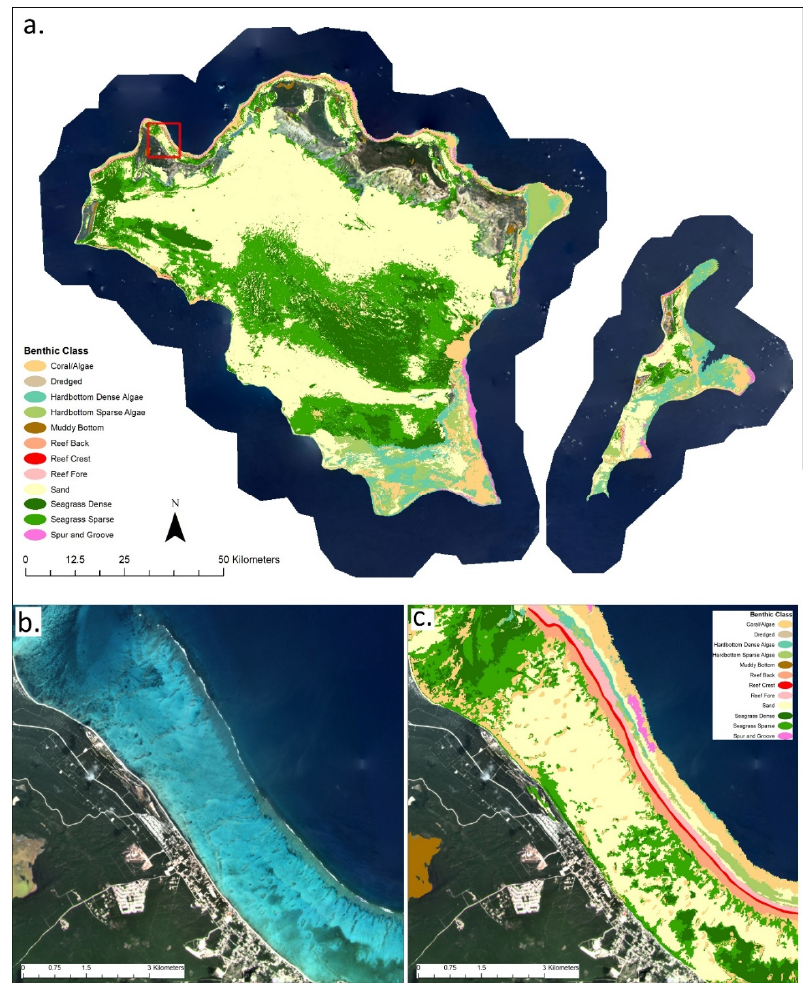
Figure 10. ( a ) An example area of the final PS image-derived benthic habitat classification for the Turks and Caicos Islands; ( b ) Zoomed-in area on the west side of Grace Bay in the northwest corner of Caicos Island showing the detail of the PS imagery; ( c ) Subsequent benthic habitat classification of the same area.